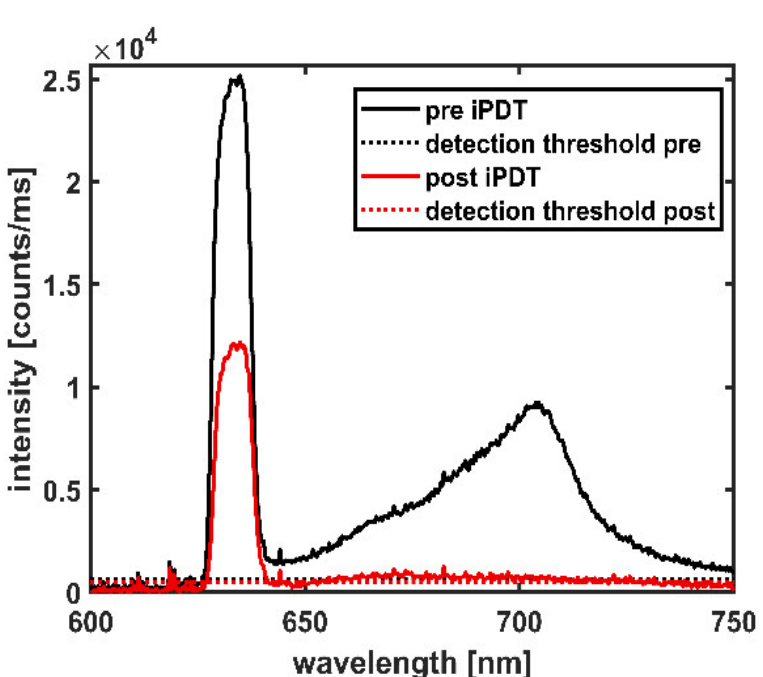
Figure 1. Spectral online monitoring data of a CDF-pair shown at iPDT start (pre iPDT, solid black line) and iPDT end (post iPDT, solid red line). Dotted lines indicate the detection thresholds.